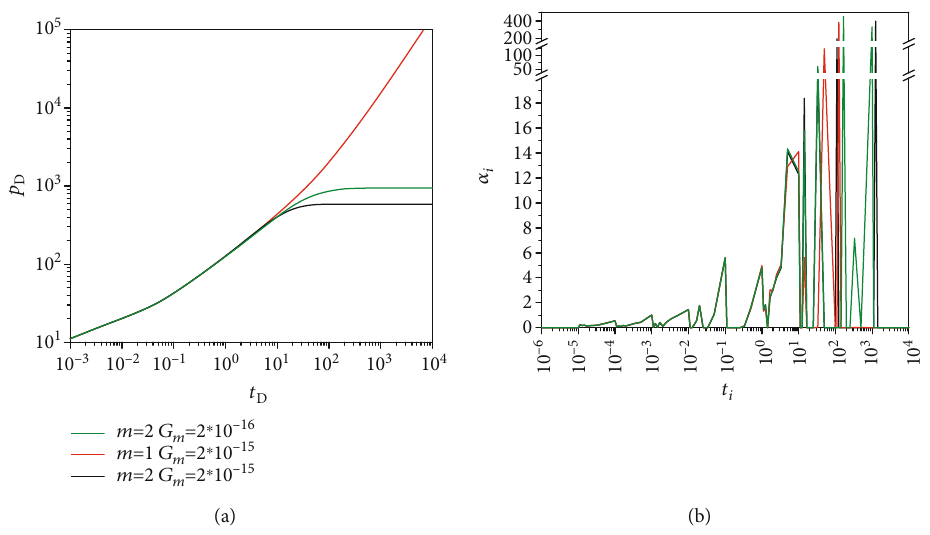
Figure 8: The wellbore gas pressure for the case with non-Darcy fl ow: (a) wellbore pressure and (b) temporal scale